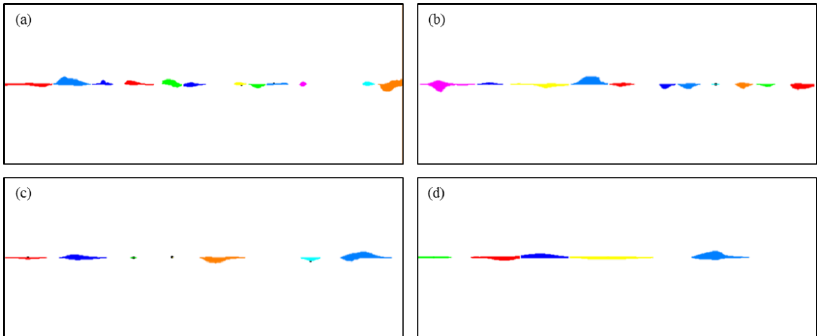
Figure 8. Image processing results showing the cavity segmentation for different characteristic lengths. ( a ), ( b ), ( c ), and ( d ) represent the results for the characteristic lengths of 0.2, 0.33, 0.5, and 1.0, respectively. Different colors are used to visually differentiate the individual cavities.